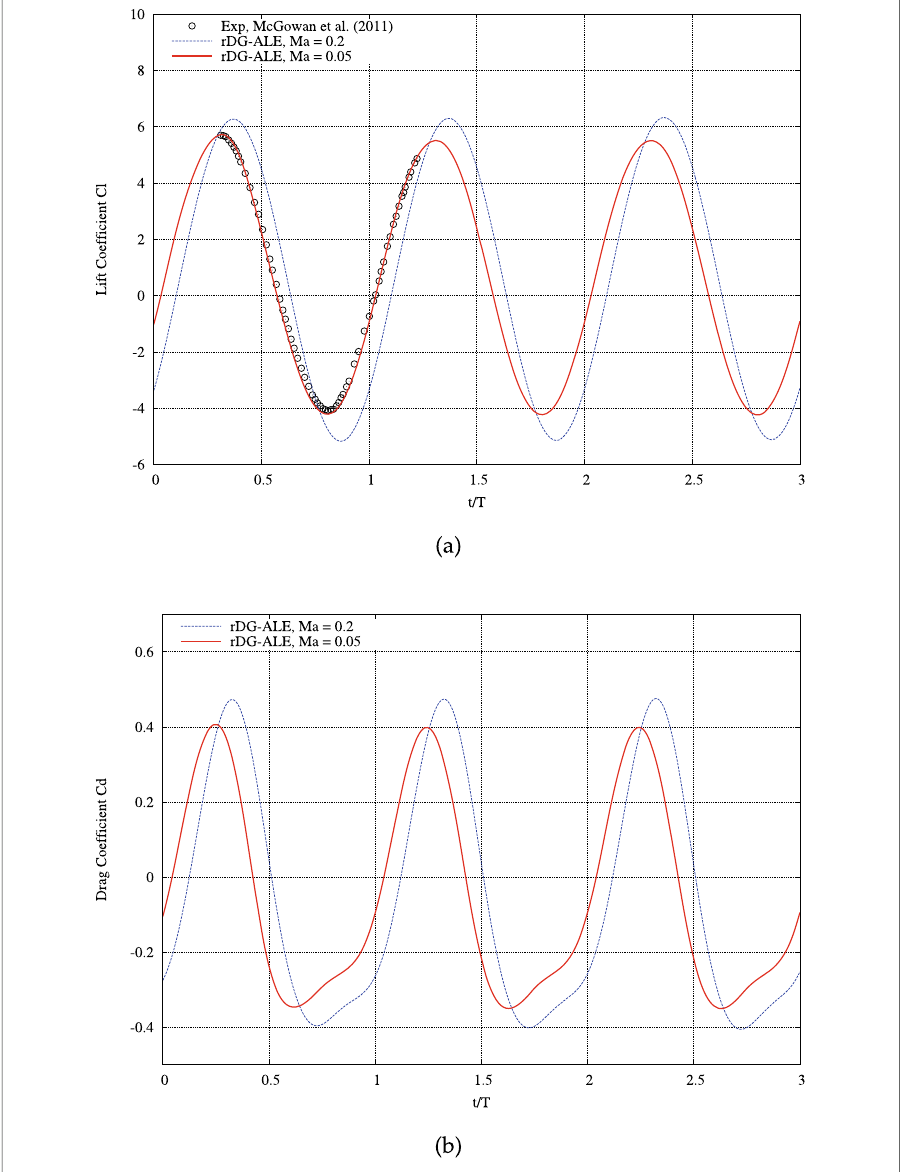
Fig. 16 Lift coefficients ( a ) and drag coefficients ( b ) versus normalized time for the plunging SD7003